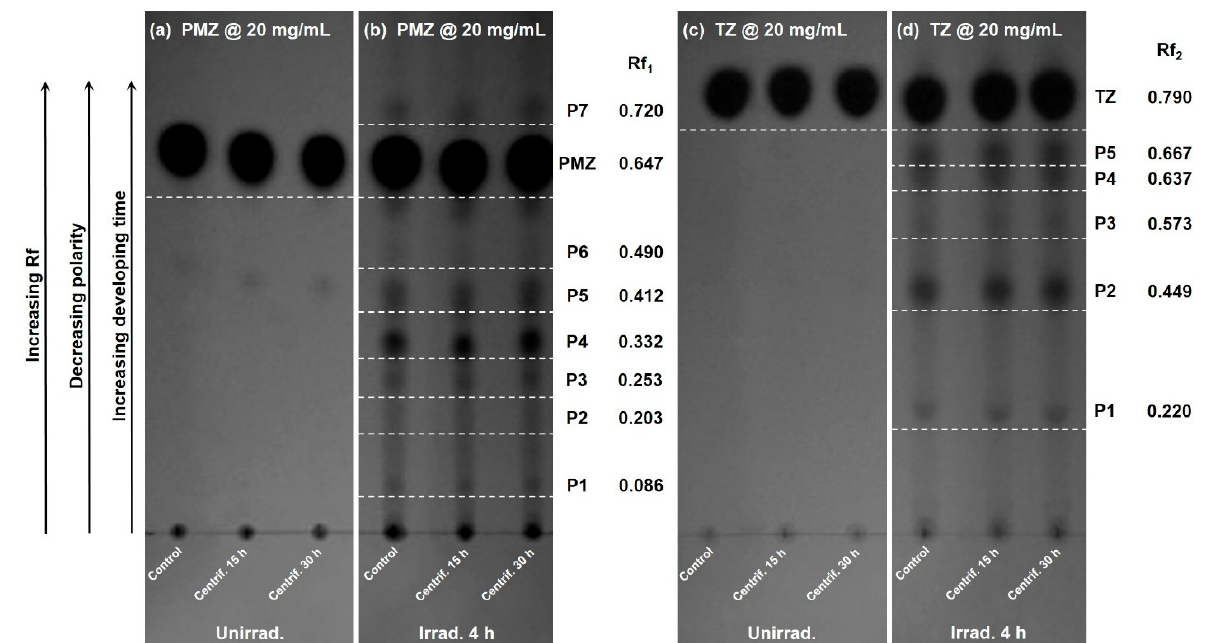
Figure 6. TLC plates with 20 mg/mL phenothiazines. Migration and separation of ( a ) unexposed PMZ, ( b ) 4 h laser-exposed PMZ, ( c ) unirradiated TZ, and ( d ) 4 h irradiated TZ after the hypergrav- ity experiment, each featuring three columns of uncentrifuged, 15 and 30 h centrifuged samples. Rf 1 —retention factors for CPZ and its photoproducts, Rf 2 —retention factors for PZ and its photo- products. Rf of photoproducts increases with the developing time, while their polarity decreases (arrow indications).